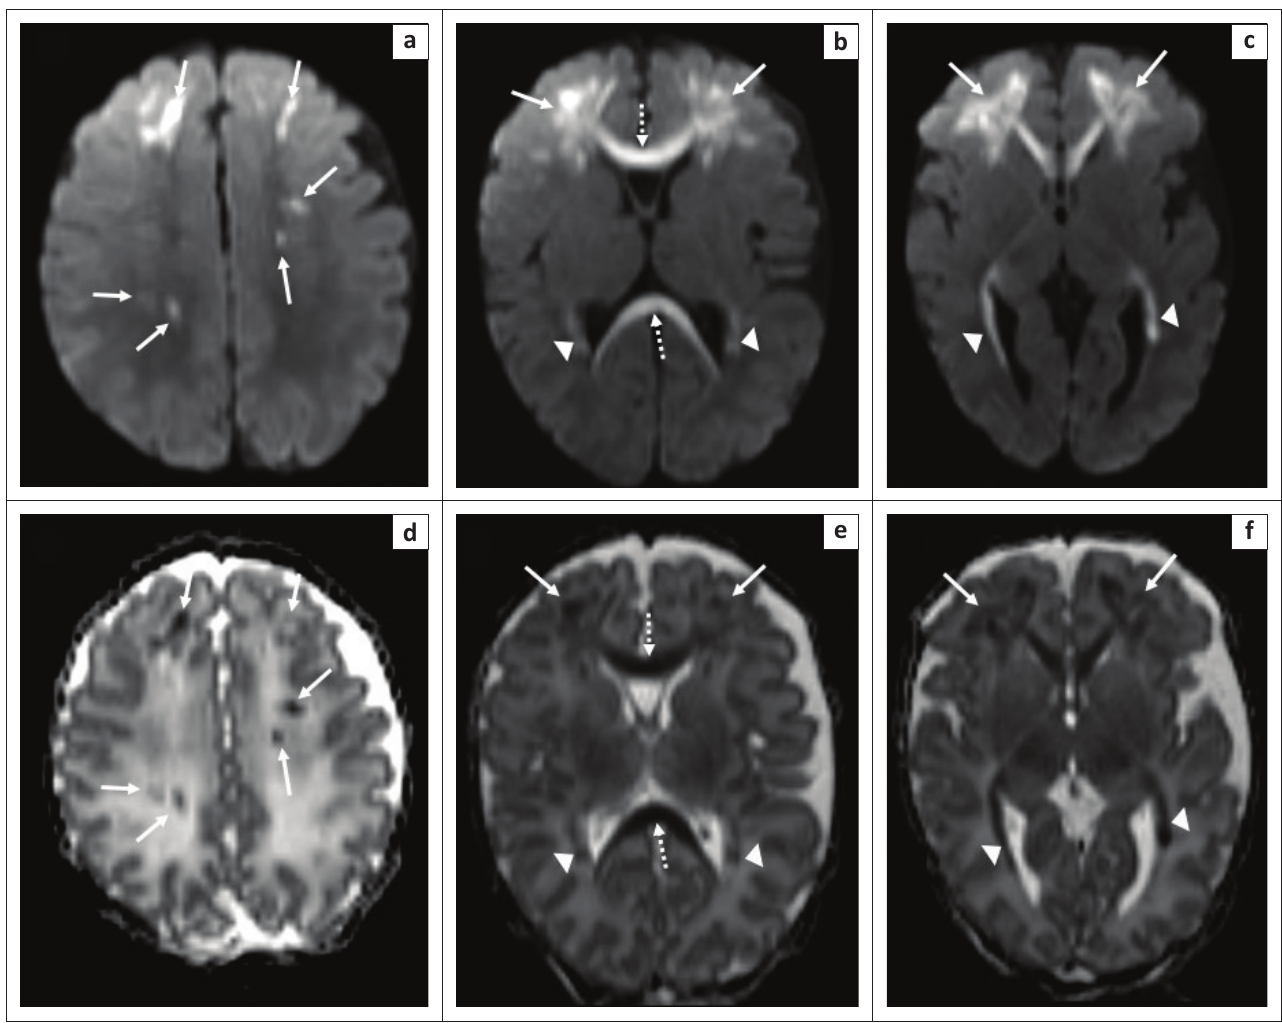
FIGURE 1: (a, b, c) Axial diffusion-weighted MRI of the brain (repetition time msec/echo time msec, 8500/100; flip angle, 90°; b -value = 1000 sec/mm 2 ) and (d, e, f) corresponding axial apparent diffusion coefficient maps (8500/100; flip angle, 90°; b- value = 1000 sec/mm 2 ) at the level of the high frontal lobes (a, d), basal ganglia (b, e) and peritrigonal white matter (c, f). Areas of restricted diffusion involving the bilateral supratentorial white matter, predominantly bilateral frontal lobes (solid white arrows on all images), corpus callosum (dashed white arrows on images [b]) and [e]) and bilateral peritrigonal periventiruclar white matter (solid white arrow heads on images [b], [c], [e] and